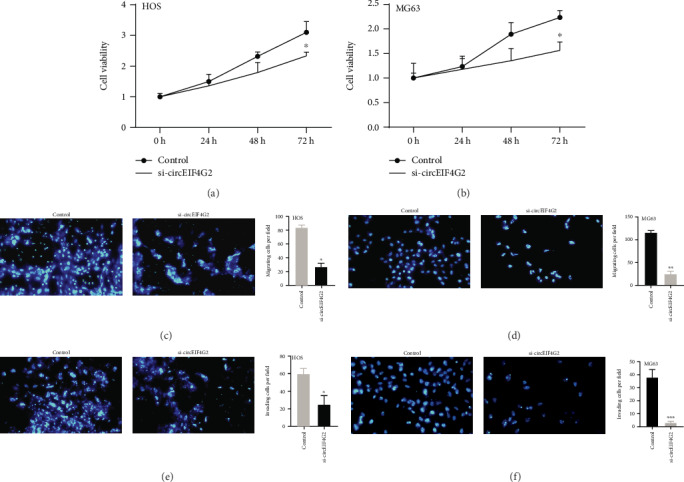
Effects of circEIF4G2 on OS cell viability, migration, and invasion ability. (a and b) Knockdown of circEIF4G2 significantly suppressed HOS (a) and MG63 (b) cell proliferation using the CCK-8 assay. (c and d) Knockdown of circEIF4G2 significantly suppressed HOS (c) and MG63 (d) cell migration using the Transwell assay. (e and f) Knockdown of circEIF4G2 significantly suppressed HOS (e) and MG63 (f) cell migration using the Transwell assay.